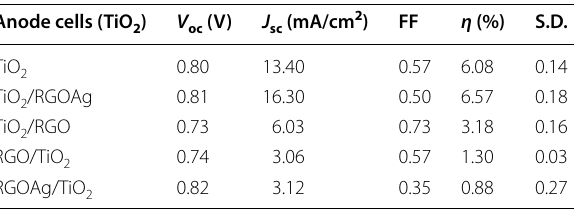
Table 3 The efficiency of the cells prepared with the most effective electrodes Anode Cathode TiO 2 TiO 2 /RGO 0.1% Pt TiO 2 /RGO 0.5% TiO 2 /RGOAg 25% Pt:RGO, 1:1